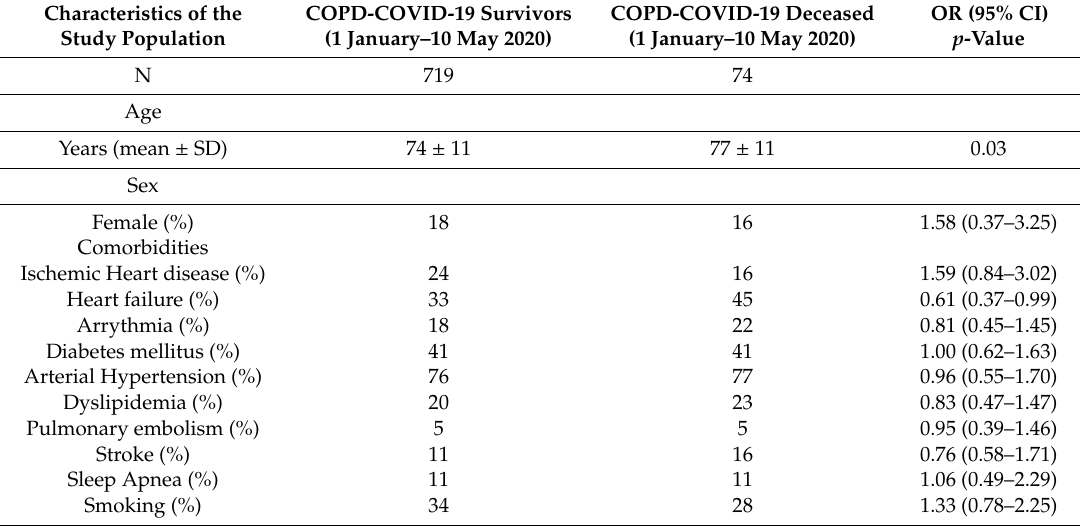
Table 3. Impact of comorbidities on the mortality of patients with COPD.